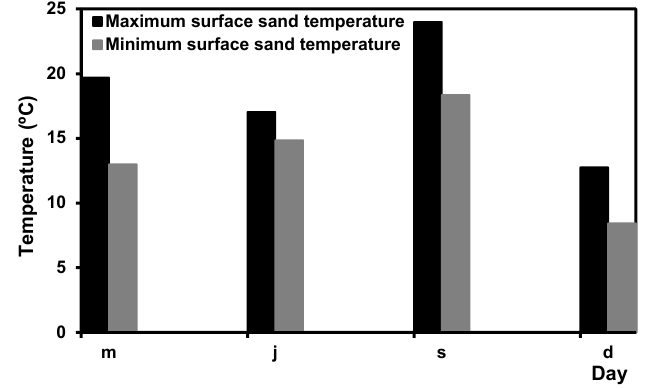
Figure 10. Maximum and minimum temperatures of the sand surface for the 15th of March (m), June (j), September (s) and December (d).